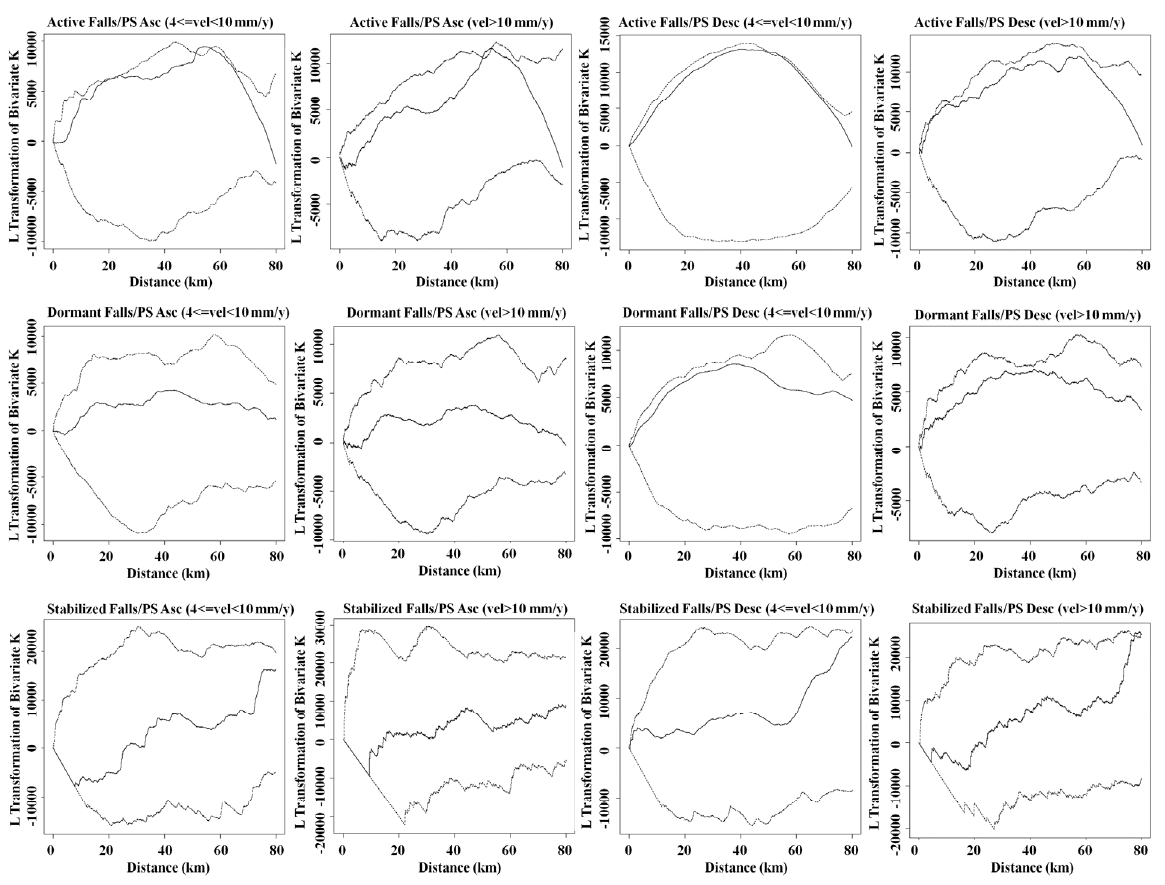
Figure 5. The result of the bivariate K-function analysis for analyzing spatial relationships between PS and occurrences of falls within the Arno River basin. Dashed lines express 98% confidence intervals and solid lines signify the observed values. Observations outside the confidence intervals indicate spatial dependence of clustering ( above ) or repelling ( below ) at corresponding scale distances. Observations inside the confidence indicate spatial